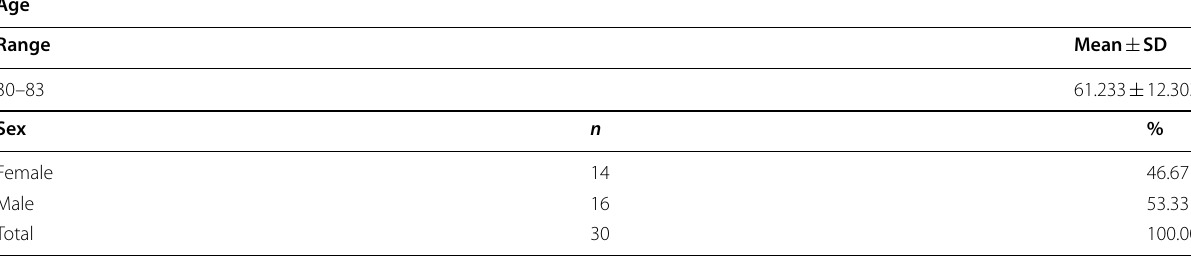
Table 1 Gender and age distribution among the study group